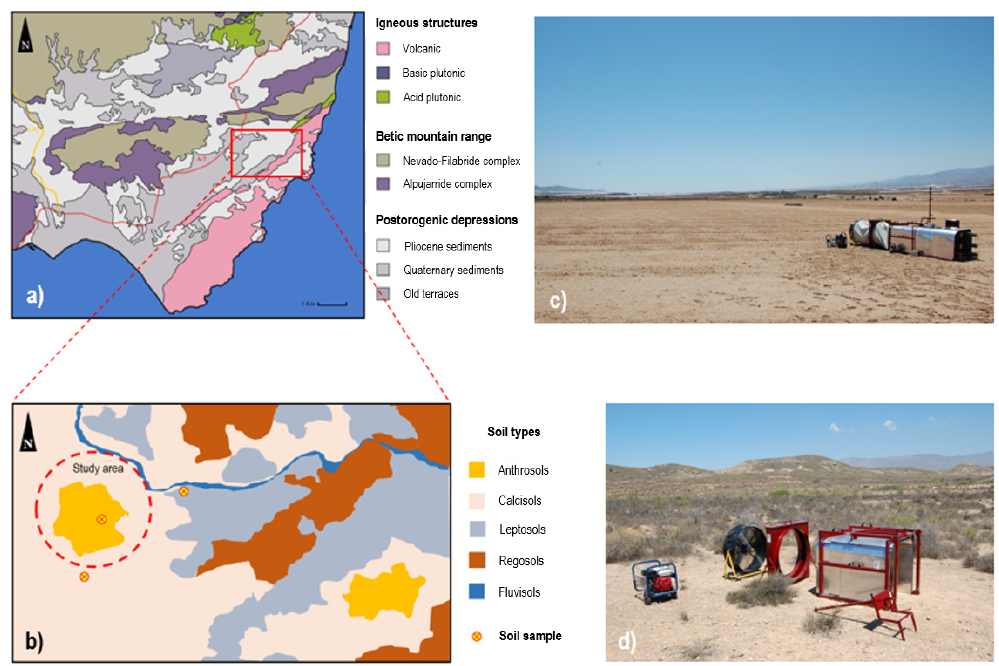
Figure 2. ( a ) Lithological location [21]; ( b ) soils map; ( c ) south view (from Anthrosols), with a wind tunnel of a former study; ( d ) northeast view.